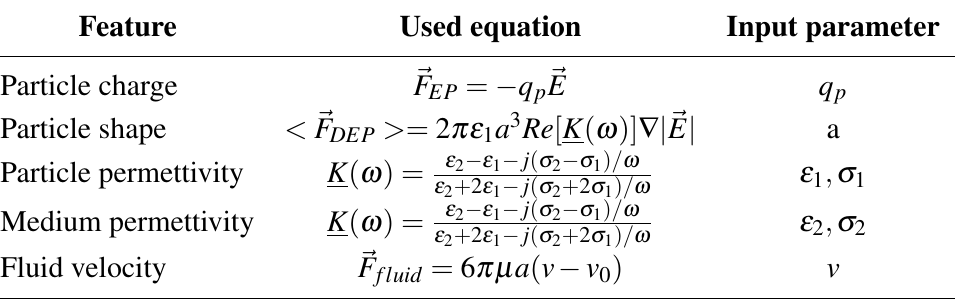
Table 2. Main proposed model